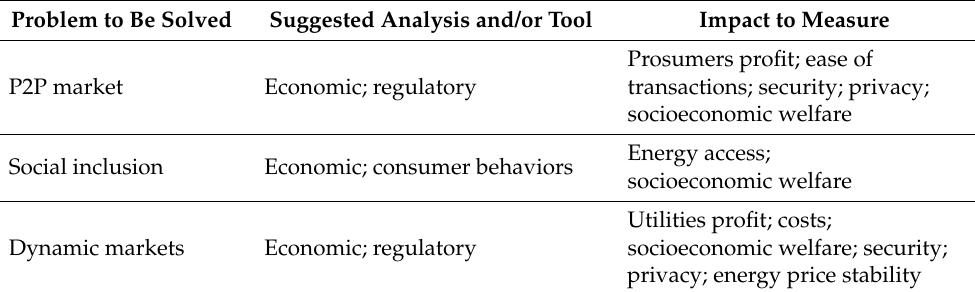
Table 9. Problems, suggestions, and impacts of P2P markets. Source: own